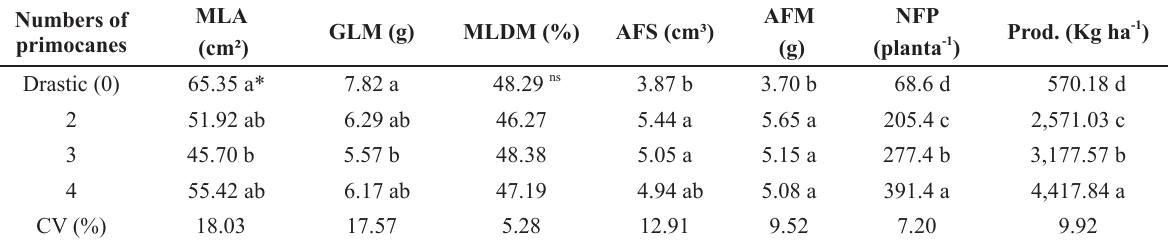
Mean leaf area (MLA), green leaf mass (GLM) mass of leaf dry matter (MLDM), average fruit size (AFS), average fruit mass (AFM), number of fruits per plant (NFP) and productivity for the various numbers of primocanes in blackberry